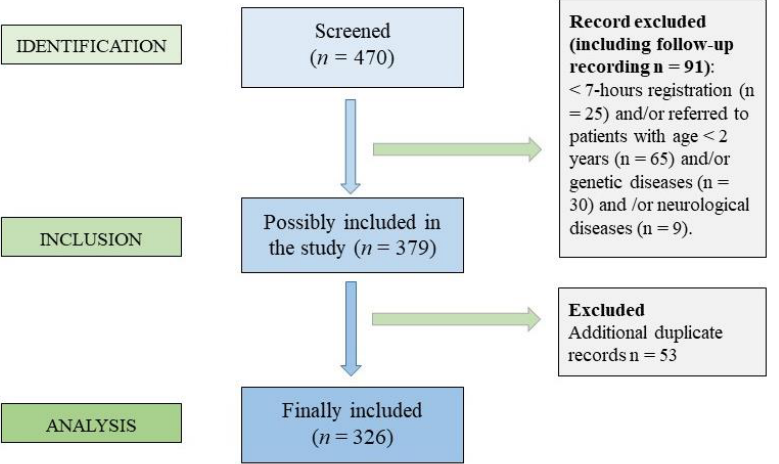
Figure 1. Flowchart showing the inclusion and exclusion criteria of the children who have performed the home cardio-respiratory polygraphy (HRP).